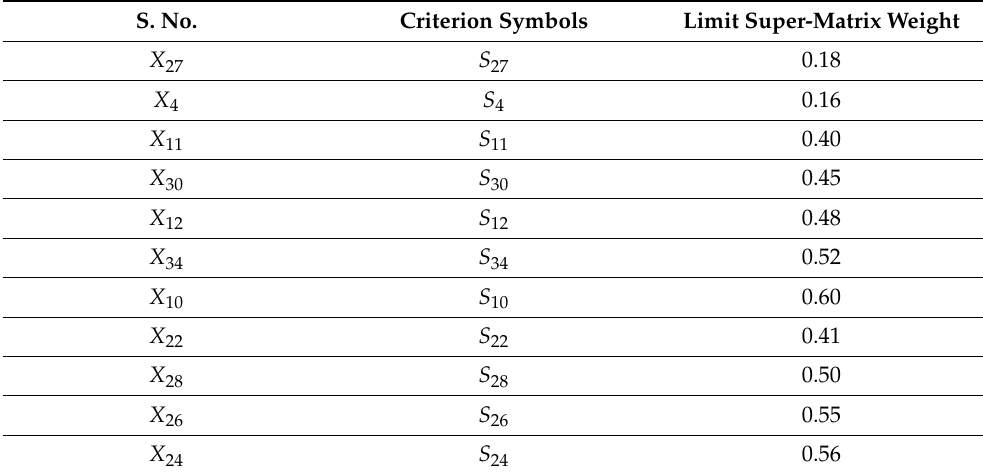
Table 8. Weights of the switches for the controller placement in cluster 5 (red). S. No.